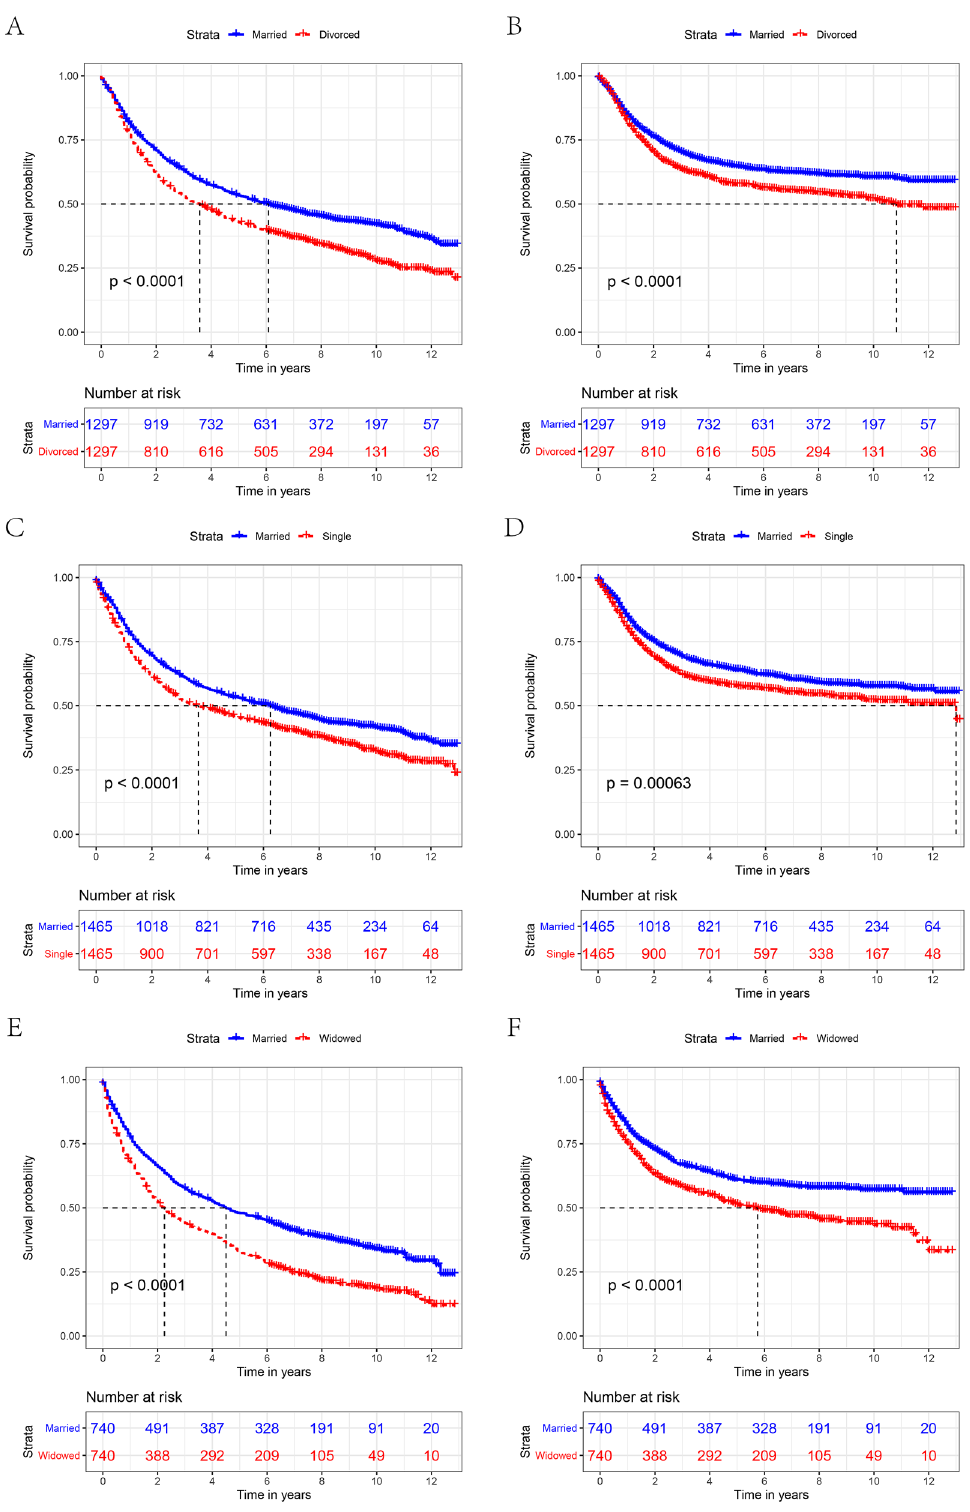
Figure 5. The OS (A, C, E) and CSS (B, D, F) of patients with laryngeal cancer according to marital status after PSM. (OS: overall survival, CSS: cause-specific